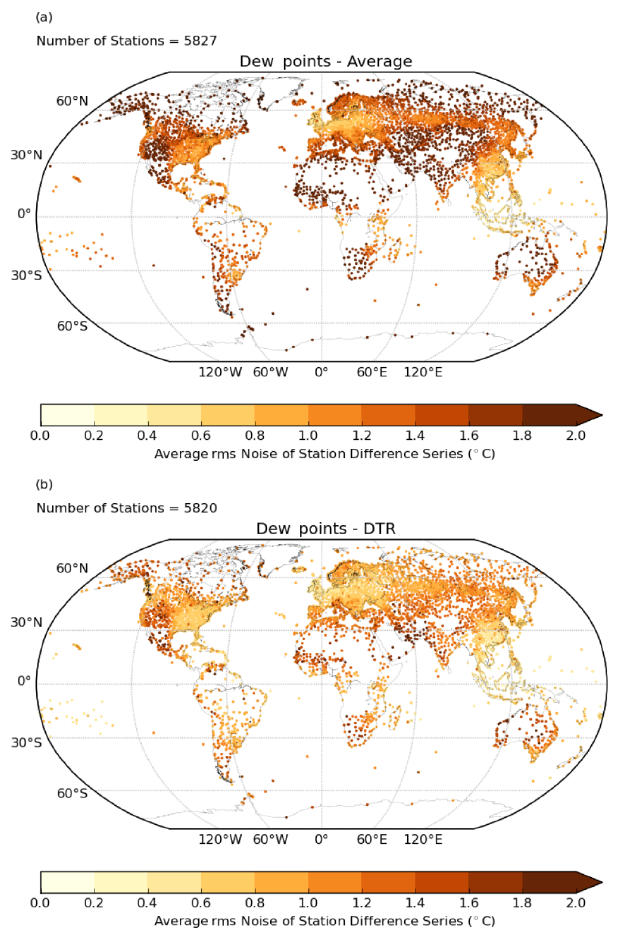
Figure A3. The average rms difference for the neighbours from each station for (a) the monthly-average dew point and (b) the monthly-average diurnal dew point range.